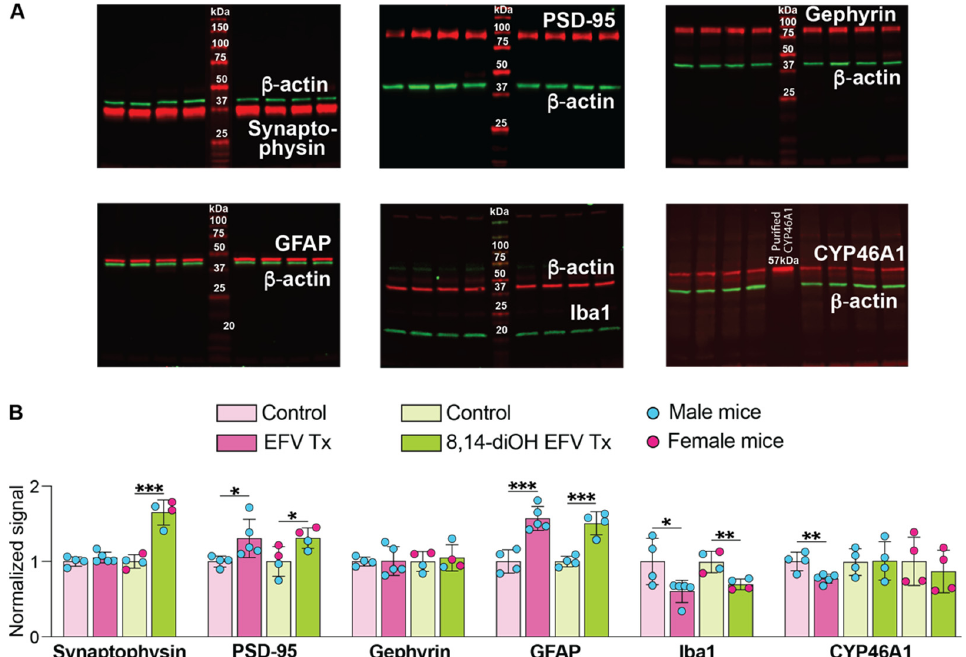
Figure 8. 8,14-DihydroxyEFV (8,14-diOH EFV) effect on brain expression of various marker proteins. ( A ), Representative Western blots of brain homogenates. Each lane, except those with molecular weight markers, represents a sample from an individual animal. Of the four samples in each group, two left lanes are always samples from male mice and two right lanes are always samples from female mice. The Western blot for CYP46A1 represents expression in male mice only as a similar gel for female mice is not shown, although quantified in the panel below. Also not shown is a Western blot for CYP46A1 when two female and two male mice for each group were used and the data suggested lack of sex-based differences and the treatment effect. ( B ), Quantification of the relative protein expression in ( A ). Protein expression in each sample within a group was first normalized to the β -actin expression followed by the calculation of the mean value of the protein expression within a group. This mean value was then normalized to the mean value of the protein expression in control 5XFAD mice, which was taken as one. The results represent the mean ± SD of the measurements in individual mice. * p ≤ 0.05; ** p ≤ 0.01, *** p ≤ 0.001 as assessed a two-tailed, unpaired Student’s test. Data for protein expression of EFV-treated mice are shown for comparison and are taken from [7].